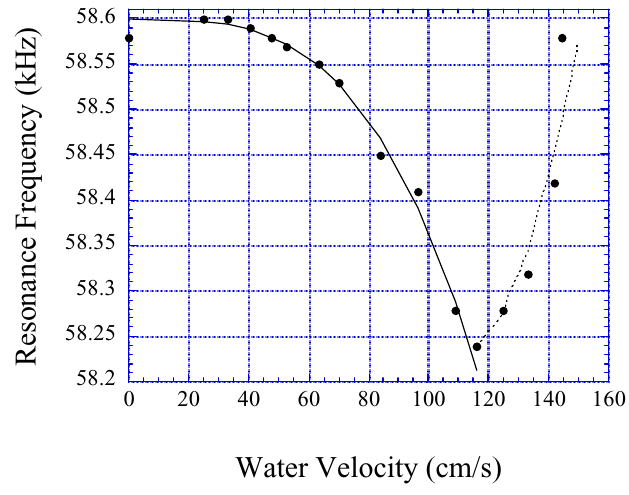
Water Velocity (cm/s) Figure 12. The resonant frequency decreases quadratically at laminar liquid flow